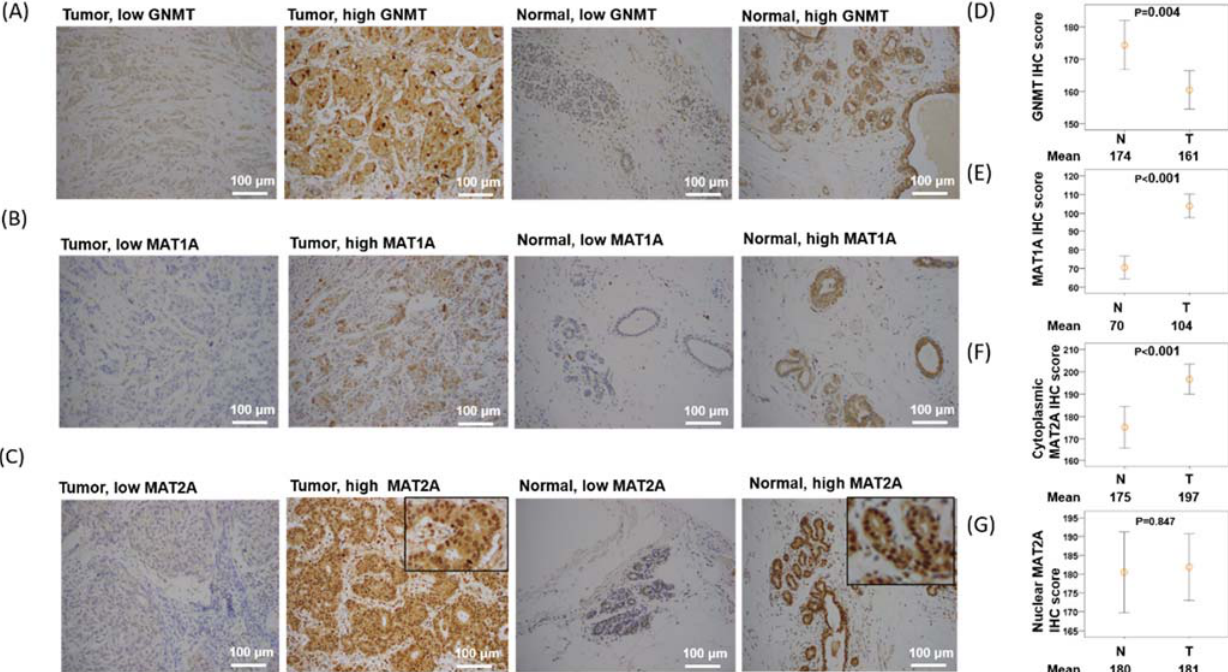
Figure 2. GNMT, MAT1A, and MAT2A immunohistochemical staining in selected cases of breast cancer (×200). ( A ) Low and high GNMT staining in breast cancer tissues and normal breast tissues. ( B ) Low and high MAT1A staining in breast cancer tissues and normal breast tissues. ( C ) Low and high MAT2A staining in breast cancer tissues and normal breast tissues. ( D ) GNMT is overexpressed in normal tissues versus breast cancer tissues. ( E ) MAT1A is overexpressed in breast cancer tissues versus normal tissues. ( F ) Cytoplasmic MAT2A is overexpressed in breast cancer tissues versus normal tissues. ( G ) No difference is observed in nuclear MAT2A expression between breast cancer tissues versus normal tissues.